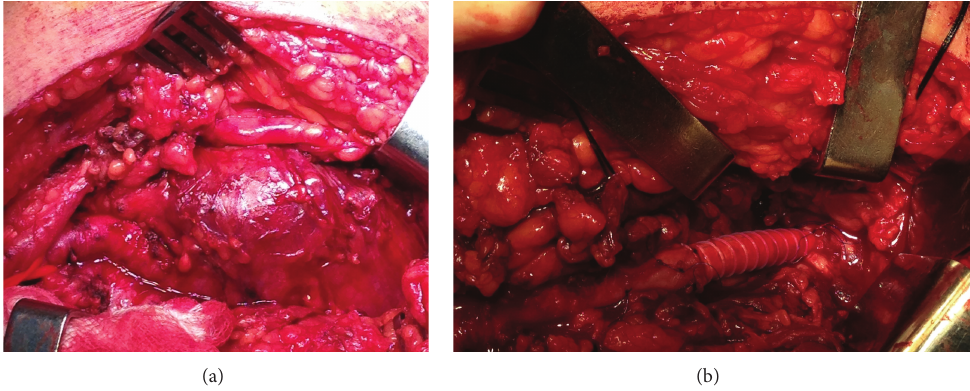
Figure 2: (a) Giant popliteal artery aneurysm intraoperatively. (b) Revascularization with polytetrafluoroethylene (PTFE) graft.